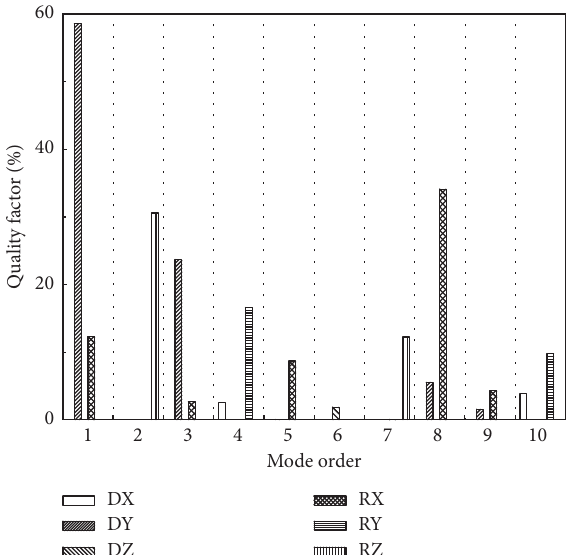
Figure 3: Mode shape mass participation coefcient.